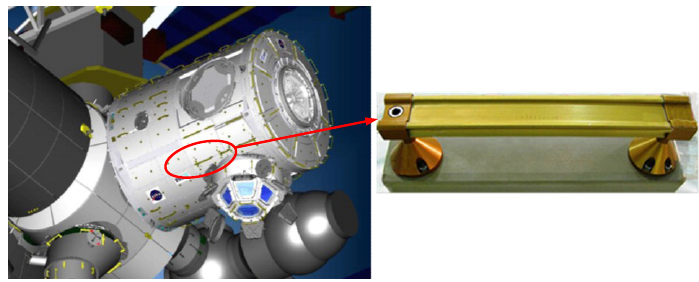
Figure 1. Handrails on extravehicular surface with appearance and dimensions.